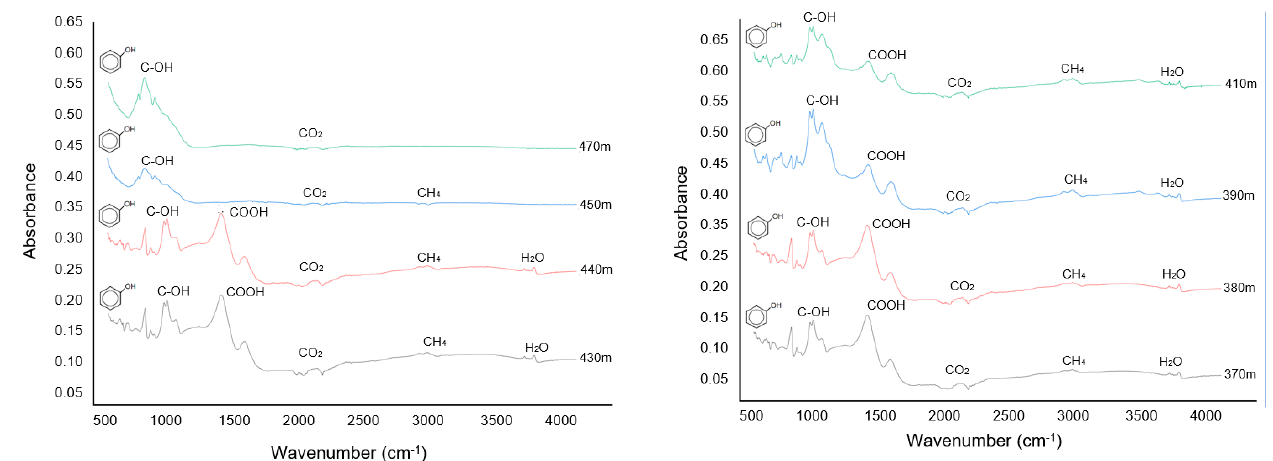
Figure 4. FTIR spectra of the studied carbonaceous shale showing functional groups representing molecules (R-OH-phenolic, C-C-OH-acetic, carboxylic, carbon (IV), COOH-carboxylic, CO 2 -carbon (IV) oxide, CH 4 -methane, H 2 O-water).